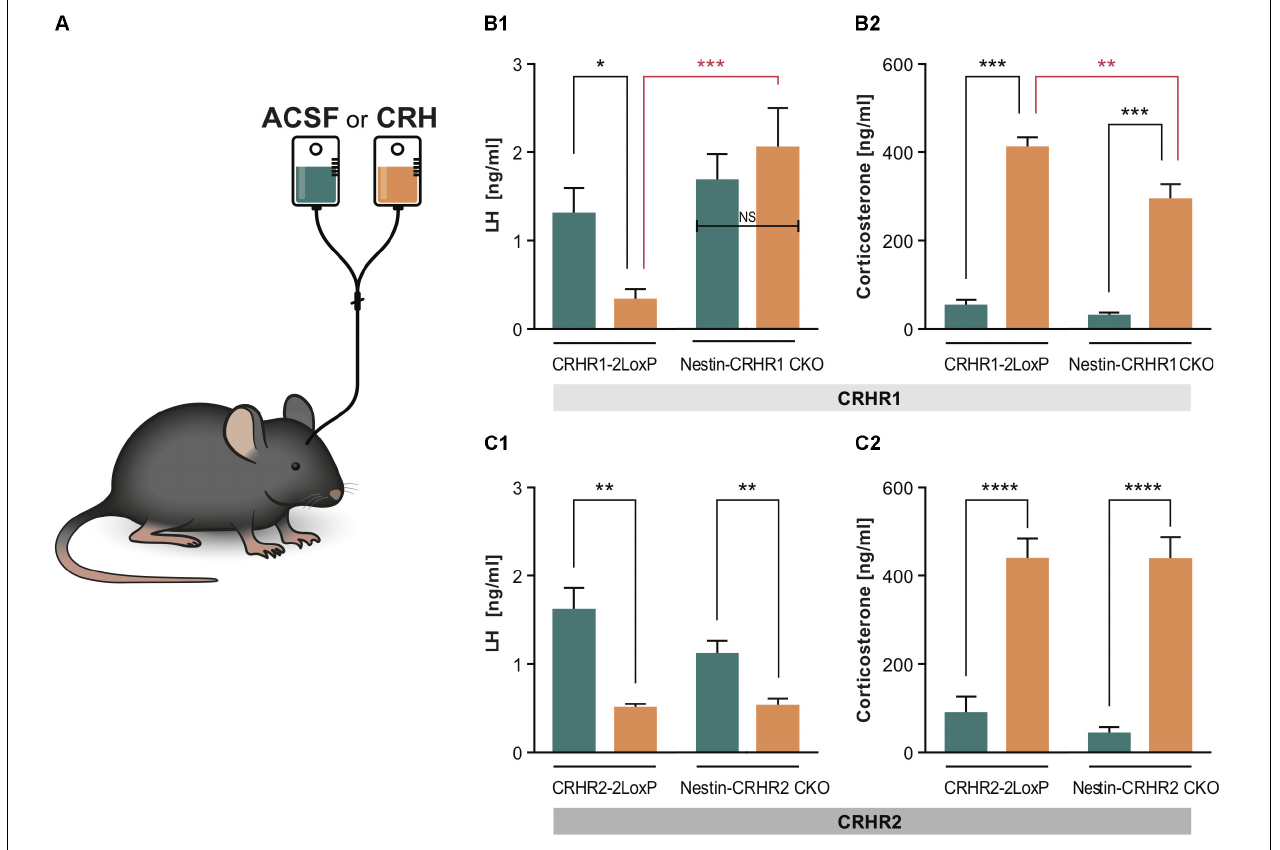
FIGURE 5 | LH and CS concentrations in Nestin- CRHR1 and CRHR2 CKO mice after central CRH infusion. (A) The i.c.v. infusion of ACSF or CRH into the lateral ventricle. (B1) After i.c.v. CRH infusion, LH concentrations were significantly lower in control CRHR1-2LoxP mice (CRH, n = 8 vs. ACSF, n = 7), but not in Nestin-CRHR1 CKO mice (CRH, n = 7 vs. ACSF, n = 7). Two-way ANOVA, F (1, 25) = 13.75, p = 0.010, followed by Bonferroni’s multiple comparisons test (ACSF vs. CRH in CRHR1-2LoxP, ∗ p = 0.043, and CRH vs. ACSF in Nestin-CRHR1 CKO, NS, p = 0.7539). Furthermore, after CRH infusion, the LH levels were significantly decreased in the control CHR1-2LoxP mice when compared to the LH levels of Nestin-CRHR1 CKO mice, ∗∗∗ p = 0.0004. (B2) After CRH infusion, the CS levels were significantly increased in both groups of animals (either in CRHR1-2LoxP or Nestin-CRHR1 CKO mice) when compared to their respective CS levels after ASCF infusion. Two-way ANOVA, F (1, 25) = 6.67, p = 0.0160, followed by Bonferroni’s multiple comparisons test (CRH vs. ACSF in CRHR1-2LoxP mice, ∗∗∗ p < 0.0001 and ACSF vs. CRH in Nestin-CRHR1 CKO mice, ∗∗∗ p < 0.0001). Interestingly, the CS levels of the CKO mice were found to be statistically reduced when compared to those of CRHR1-2LoxP mice after CRH infusion ( ∗∗ p < 0.05). (C1) In contrast, after CRH infusion, plasma LH concentrations were found to be significantly decreased in control CRHR2-2LoxP mice (ACSF n = 5 vs. CRH, n = 6), and in Nestin-CRHR2 CKO mice (CRH, n = 6 vs. ACSF, n = 5). Two-way ANOVA, F